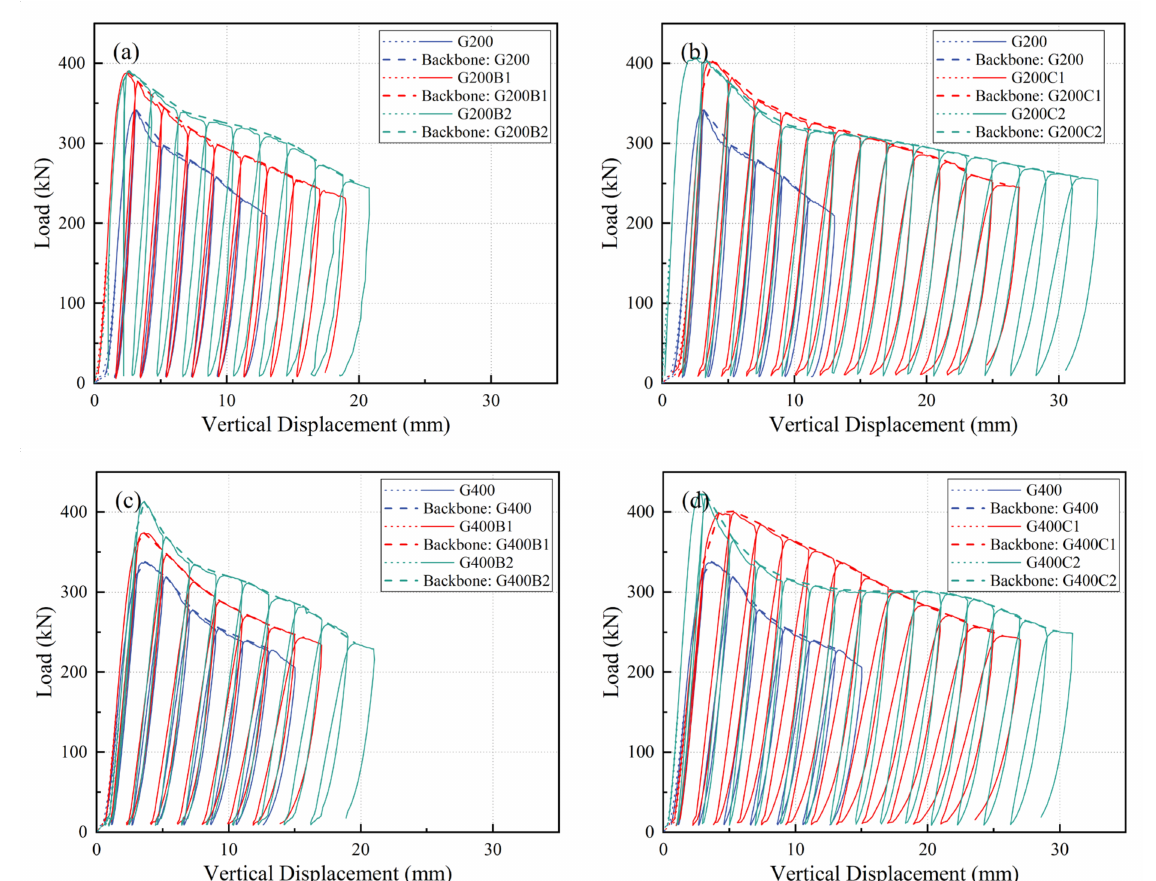
Figure 9. Hysteresis loops and backbone curves of FRP confined GLT columns: ( a ) BFRP confined G200 specimens; ( b ) CFRP confined G200 specimens; ( c ) BFRP confined G400 specimens; ( d ) CFRP confined G400